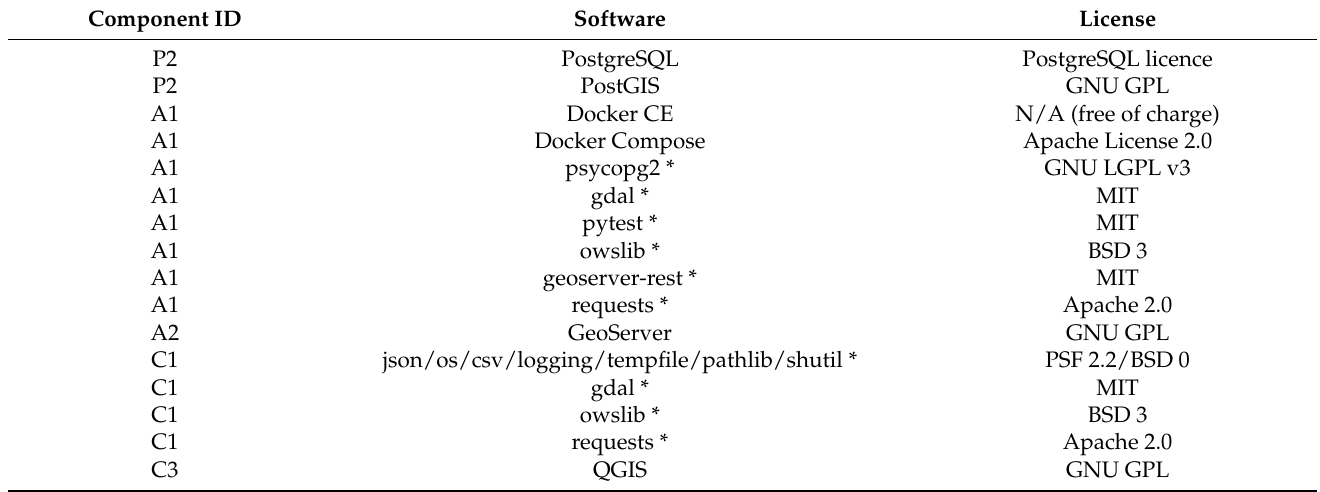
Table A1. Open-source software used by the ST_LUCAS system. Component IDs reflect the system architecture as presented in Figure 3.